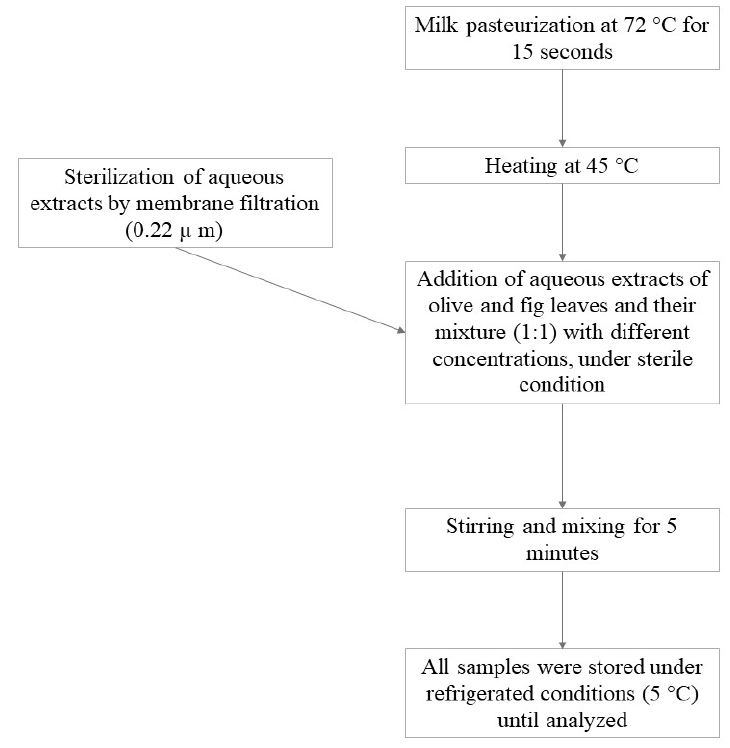
Figure 1. Pasteurized buffalo milk enriched with different concentrations of aqueous leaves’ extracts (olive and fig and their mixture “1:1”).